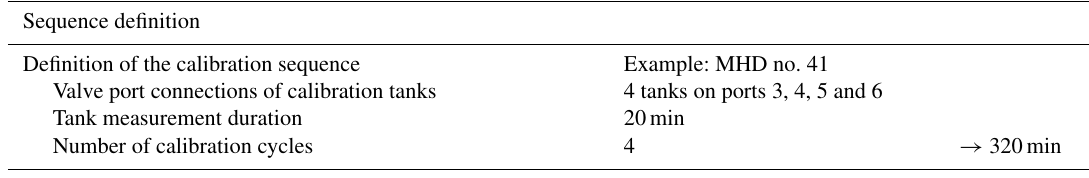
Table 3. Definition of a measurement sequence. As an example, we show the configuration for the instrument installed at Mace Head station (identified by the three-letter code MHD),